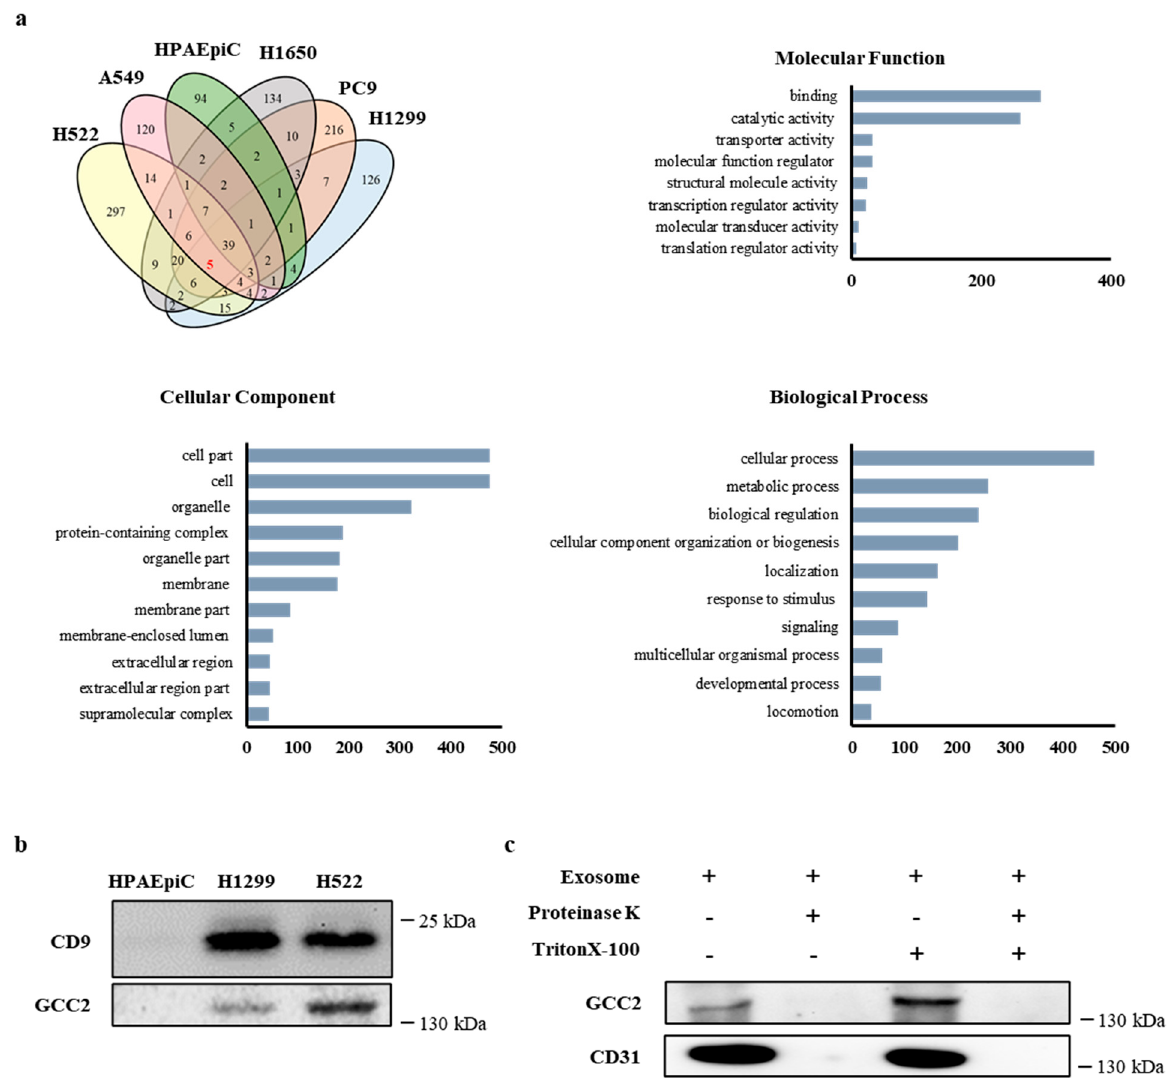
Figure 2. Identification of a potential factor for NSCLC diagnosis and treatment by proteomic analysis. ( a ) A Venn diagram for the proteomic analysis and Gene Ontology classification of the exosomes derived from six cell lines. ( b ) GCC2 expression in the exosomal lysates determined by western blotting. ( c ) GCC2 protein present on both the surface and inside the exosomes. The GCC2 protein disappeared following the exposure of the exosomal surface proteins to proteinase K.